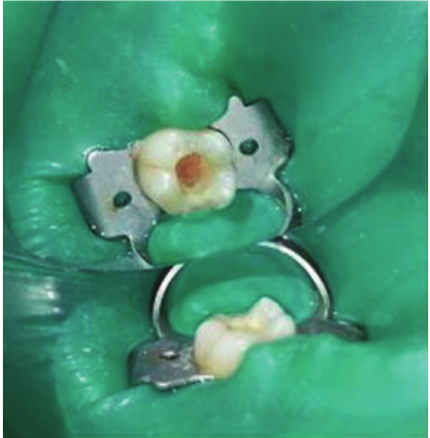
Figure 32: Preoperative photograph 36.